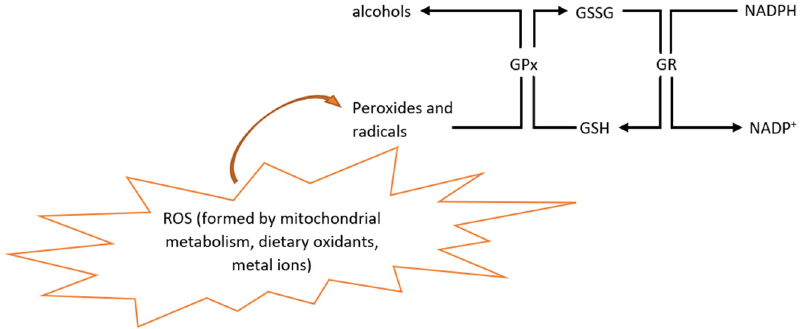
Figure 2. Glutathione mechanism for the neutralization of ROS. GPx neutralizes peroxides and radicals. In this process, GSH is oxidized to GSSG. GR reduces GSSG again to GSH in the presence of NADPH. GPx = glutathione peroxidase; GR = glutathione reductase; GSH = reduced glutathione; GSSG = oxidized glutathione; ROS = reactive oxygen species; NADPH = nicotinamide adenine dinucleotide phosphate.